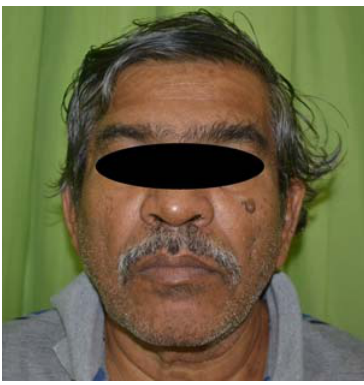
Figure 2. T1 weighted Magnetic Resonance Imaging of pituitary with gadolinium enhancement – coronal section: Pretreatment Figure 1. Pretreatment patient homogenous enlargement of the pituitary gland extending into – coarse facial features with suprasellar region without chiasmatic compression (A) and post large nose. treatment image with reduced size and bulkiness of the gland